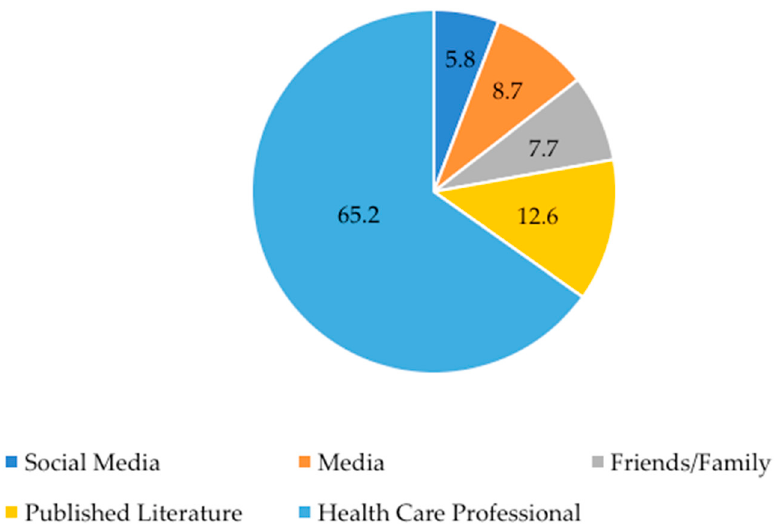
Figure 2. Primary information sources about dietary supplements. Data is presented as % of respondents. Participants could only choose one source or answer in the “other” section. One participant indicated in the “other” section that they use a combination of social media and health care professionals, so a “yes” was put into each category.